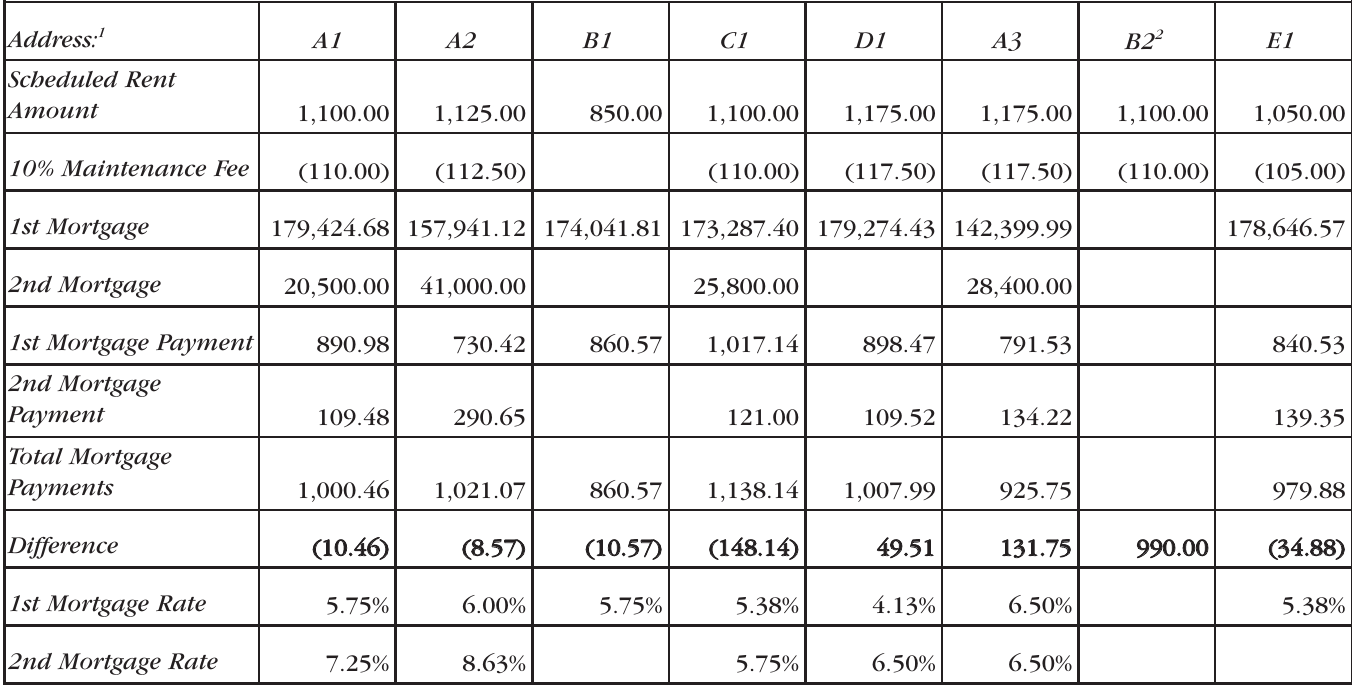
Table 3. Financial Information of D&H Management LLC Portfolio—Property Cash